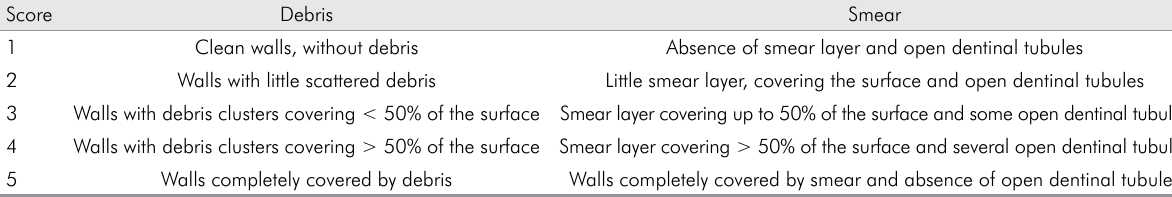
Table 1. Scores employed to classify debris and smear layer removal.